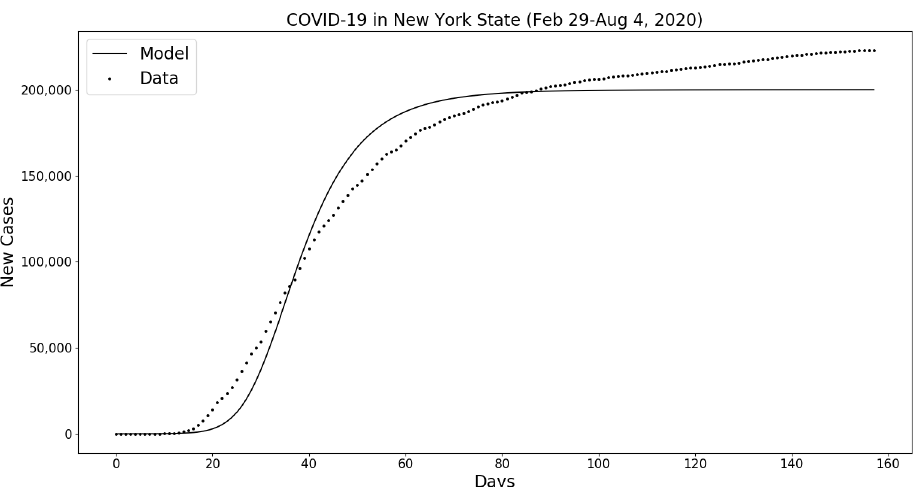
Figure A9. The horizontal axis represents the time in days and the vertical axis represents the cumulative number of new COVID-19 cases from the model simulations and actual data (data are from [48,49]). The values of the parameters are as follows: µ = 3.37 × 10 − 5 per day [50], b = 6.4 × 10 − 4 pop. per day [51], N 0 = 19.8 millions [51], β I = 0.066 per day, t 0 = 30 days, n H = 5, and the values for the other parameters are as in Table 2. RE = 23.2% and R 0 =